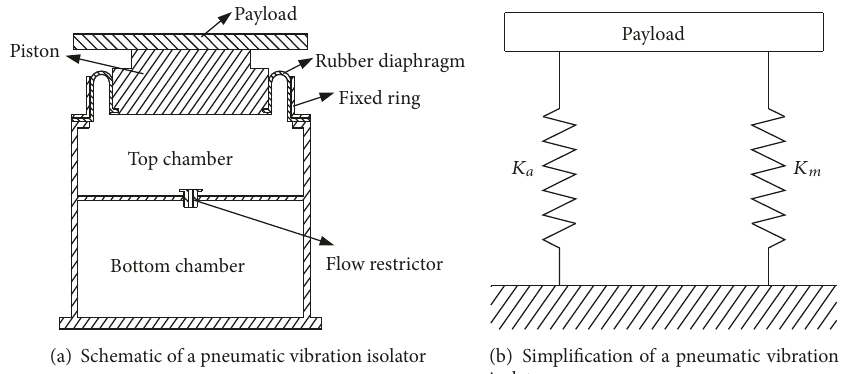
Figure 1: Pneumatic vibration